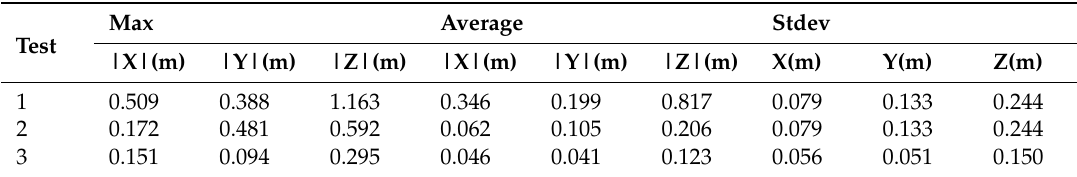
Figure 13. Spatial distribution of orientation residual without GCP: ( a ) horizontal residual distribution; and ( b ) vertical residual distribution. Table 8. Comparison of orientation residual of three experiments. Table 8. Comparison of orientation residual of three